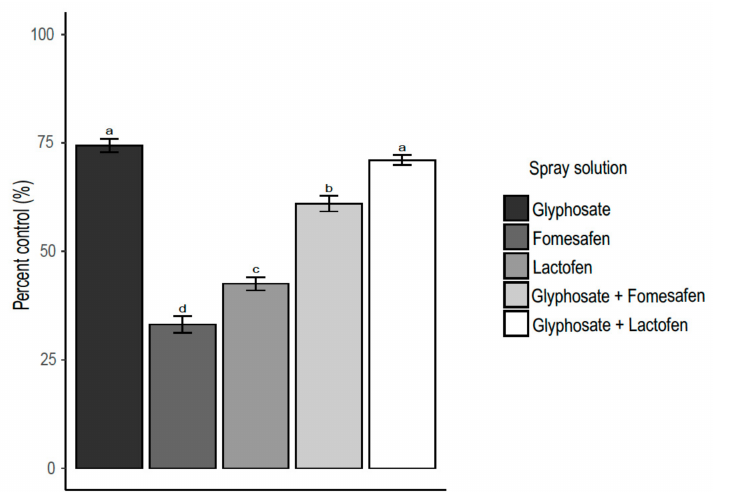
Figure 1. Percent of Palmer amaranth control based on visual estimations of injury at 28 DAT treated with different herbicide tank-mixtures averaged across nozzle types evaluated from a field study conducted in 2016. Bars with same letter do not differ using Tukey post-hoc test at α = 0.05.